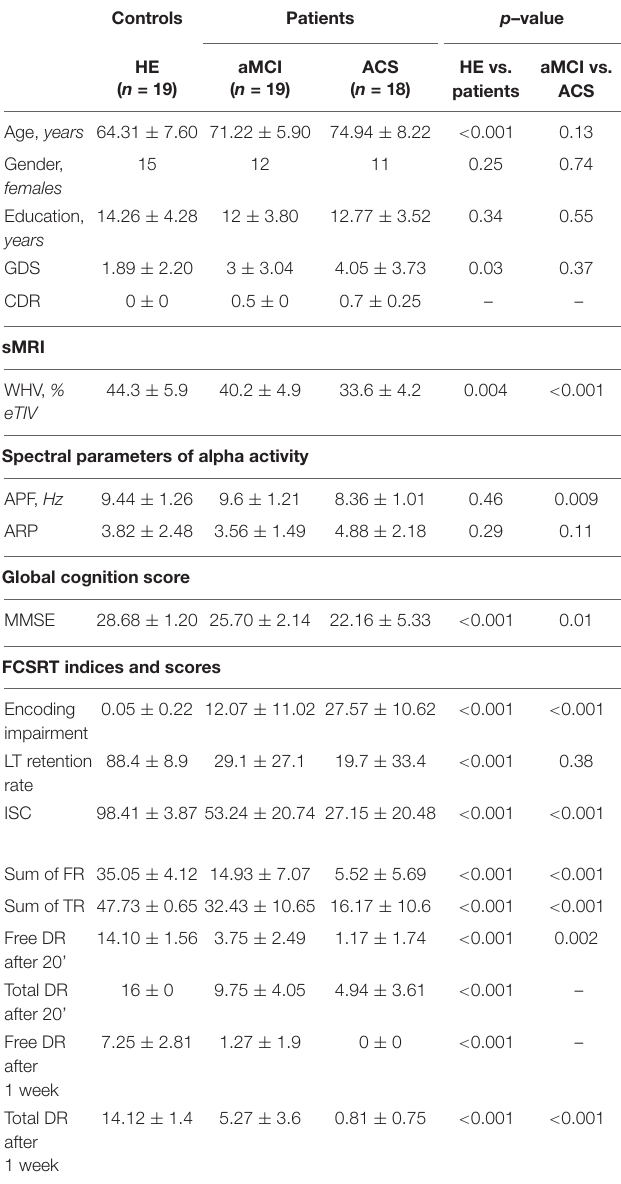
TABLE 1 | Participants’ demographic and clinical data for healthy elders (HE) and patients. Controls